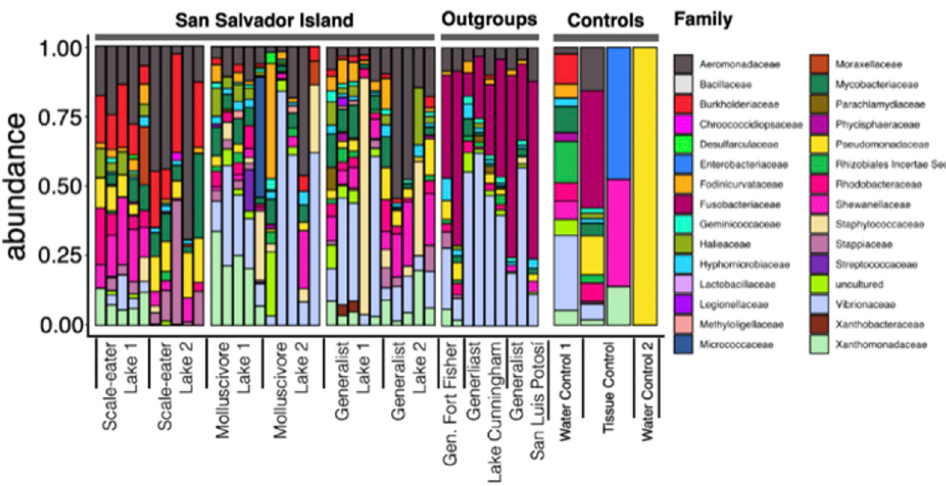
Fig 3. Taxa plot of the microbial composition of the Cyprinodon gut microbiome and controls. Bars show proportions (relative abundance) of taxa at the family level per individual gut microbiome. Lake 1 indicates Crescent Pond and Lake 2 represents Osprey Lake, both located on San Salvador Island in the Bahamas. Taxa which contained uncharacterized and Opisthokonta (eukaryotic sequences) were removed and taxa with a count of 400 or greater were represented. Taxa were grouped according to species and location (controls